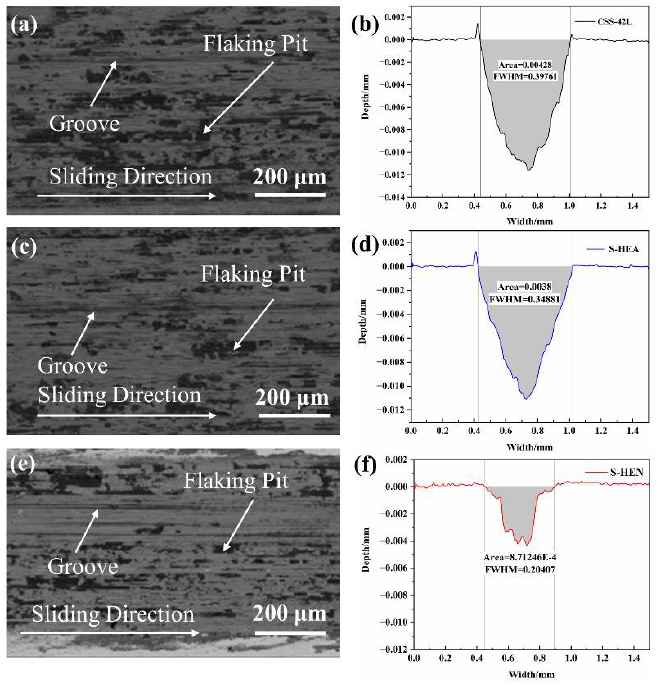
Figure 11. The surface topography and cross-sectional profile of wear track: ( a , b ) CSS-42L, ( c , d ) S-HEA sample, ( e , f ) S-HEN sample.